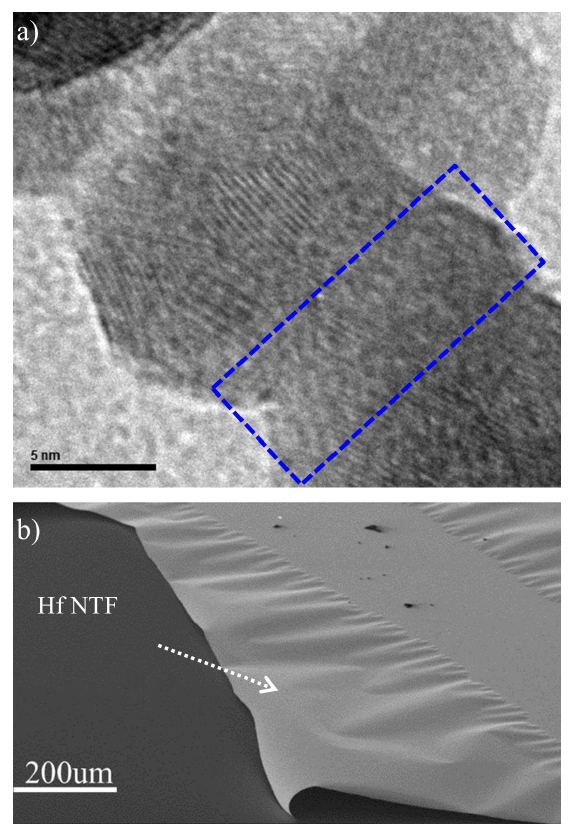
Figure 10: a) HRTEM image showing partial coalescence of Hf NPs deposited at a substrate bias of V s = 2 kV; b) free standing Hf NTFs grown with V s = 2 kV. The film, although consisting of nanoparticles, appears cohesive. The films thickness is ca. 120